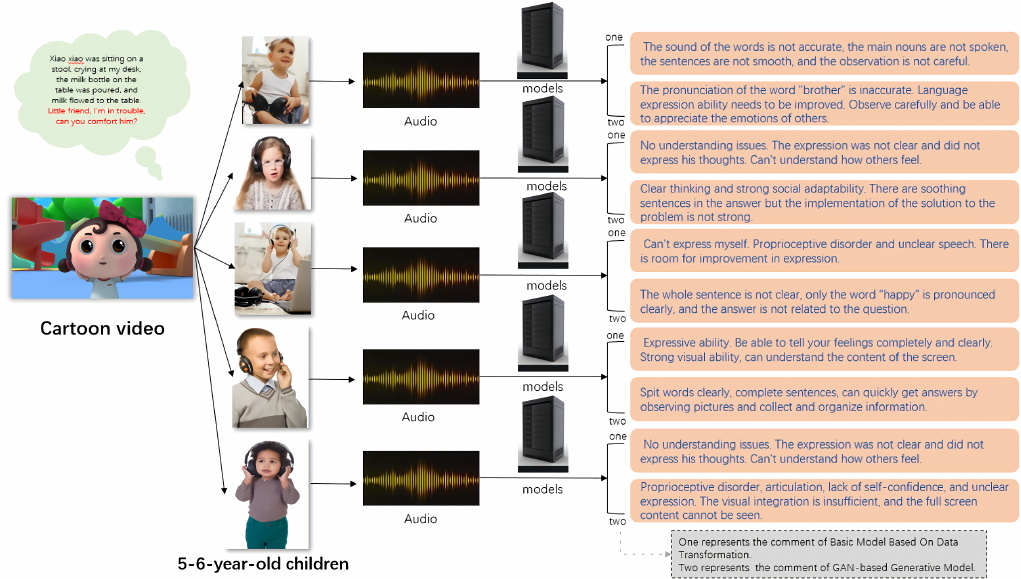
Figure 5. Experimental of an oral evaluation test for children. The participants are asked to watch a cartoon. In the cartoon, there are well designed oral questions. The participants answer the corresponding questions orally. Then, the system will automatically generate the expert comments for the participants.